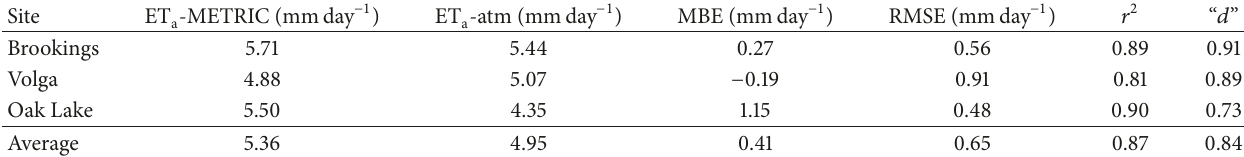
-atm at the Brookings, Volga, and Oka Lake sites. a